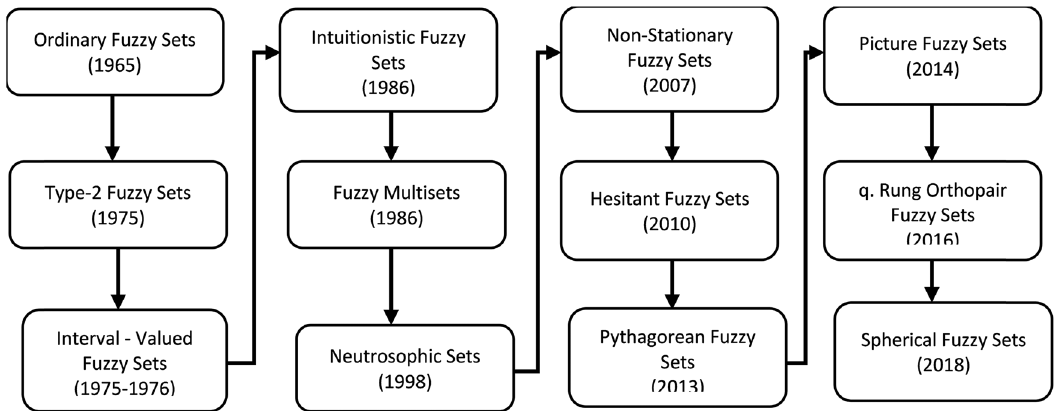
Figure 3: Fuzzy sets extensions [ 39 ] .